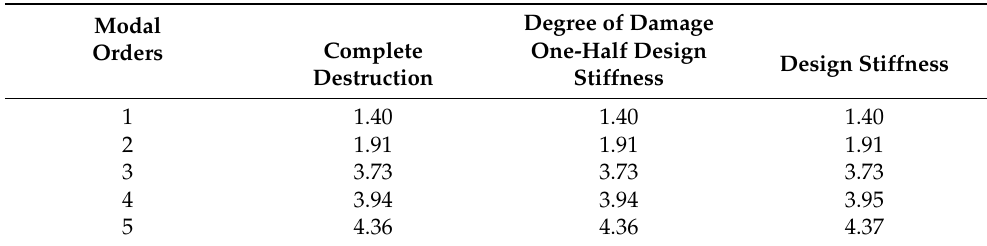
Table 11. Effect of damage to the vulnerable area of shear joints on the self-vibration frequency of the structure.